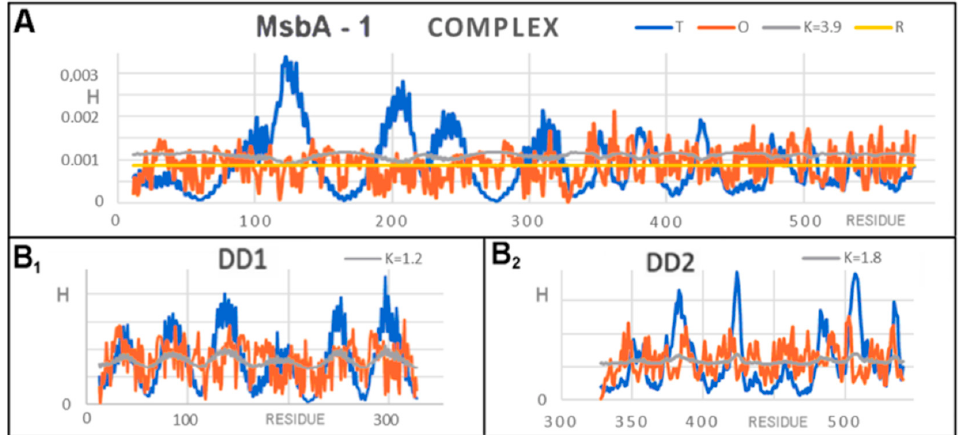
Figure 7. A set of profiles for the 6UZL homodimer 3DG and 1–3DG function assigned to the com- plex. ( A ) Distribution in chain A as a representative of the complex. Additionally, distribution R